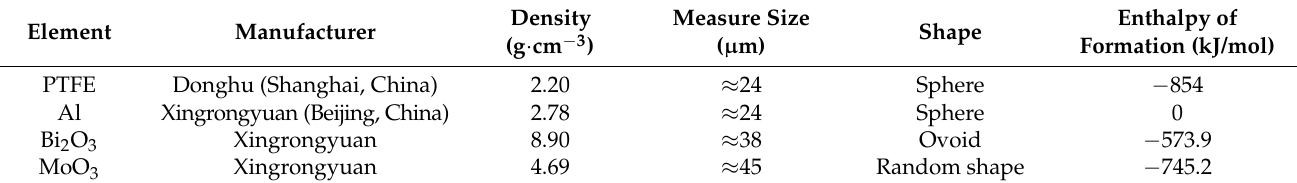
Table 1. Raw materials properties of